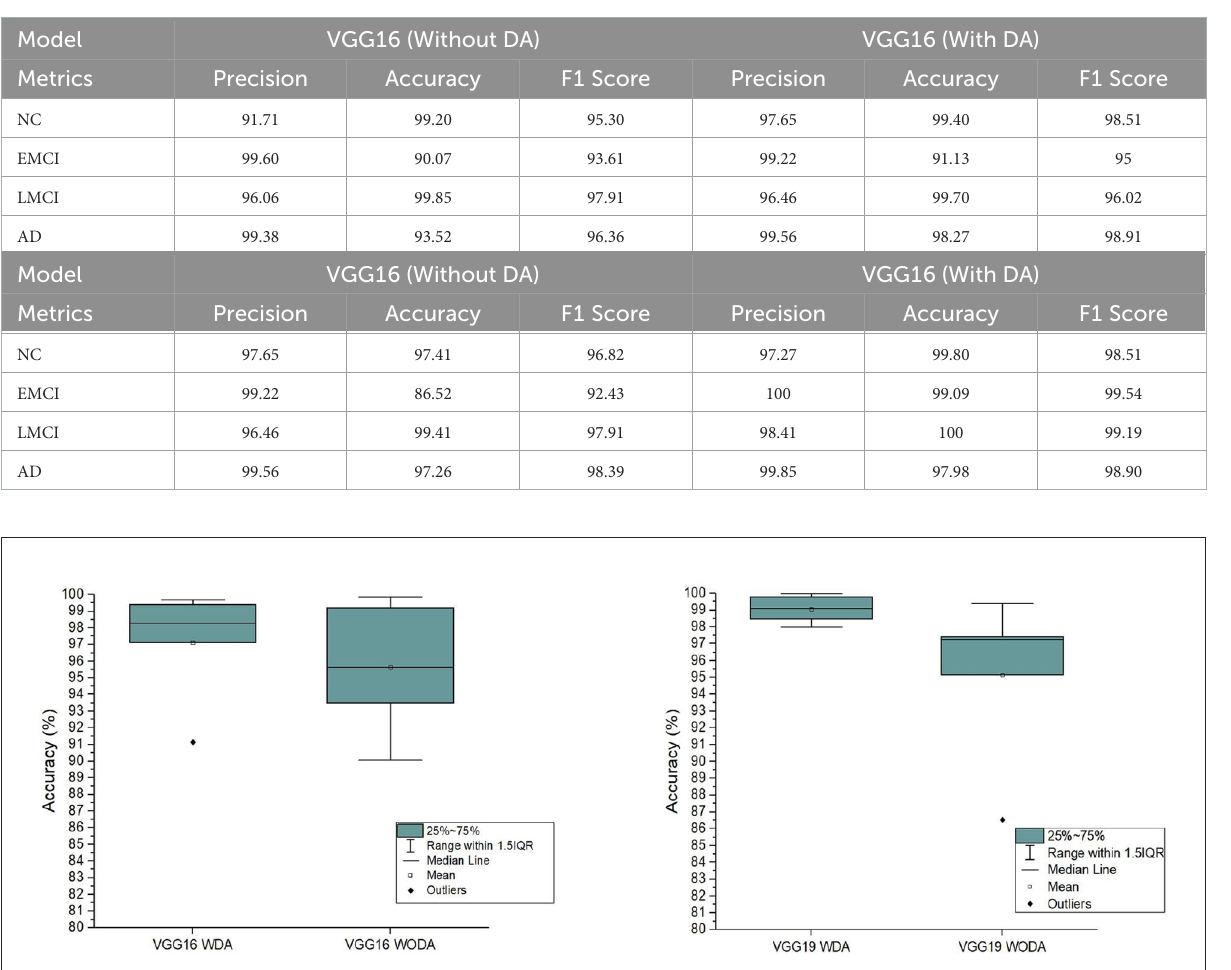
TABLE 2 The comparison of the evaluation metrics in terms of precision, accuracy, and F1 score for VGG16 and VGG19 with and without data augmentation.